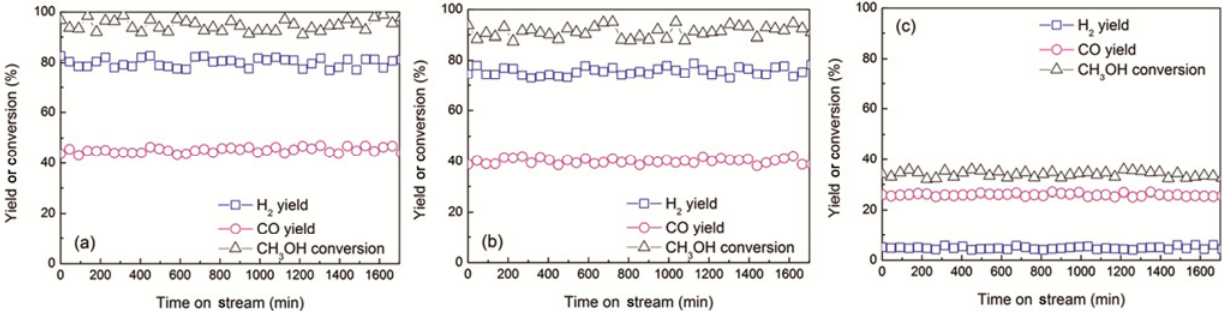
Fig. 4 Reforming performance of NiMo–Ce 0.9 Ca 0.1 O 2 − δ obtained from (a) thin catalyst layer from Cell A, (b) independent catalyst layer from Cell B, and (c) blank